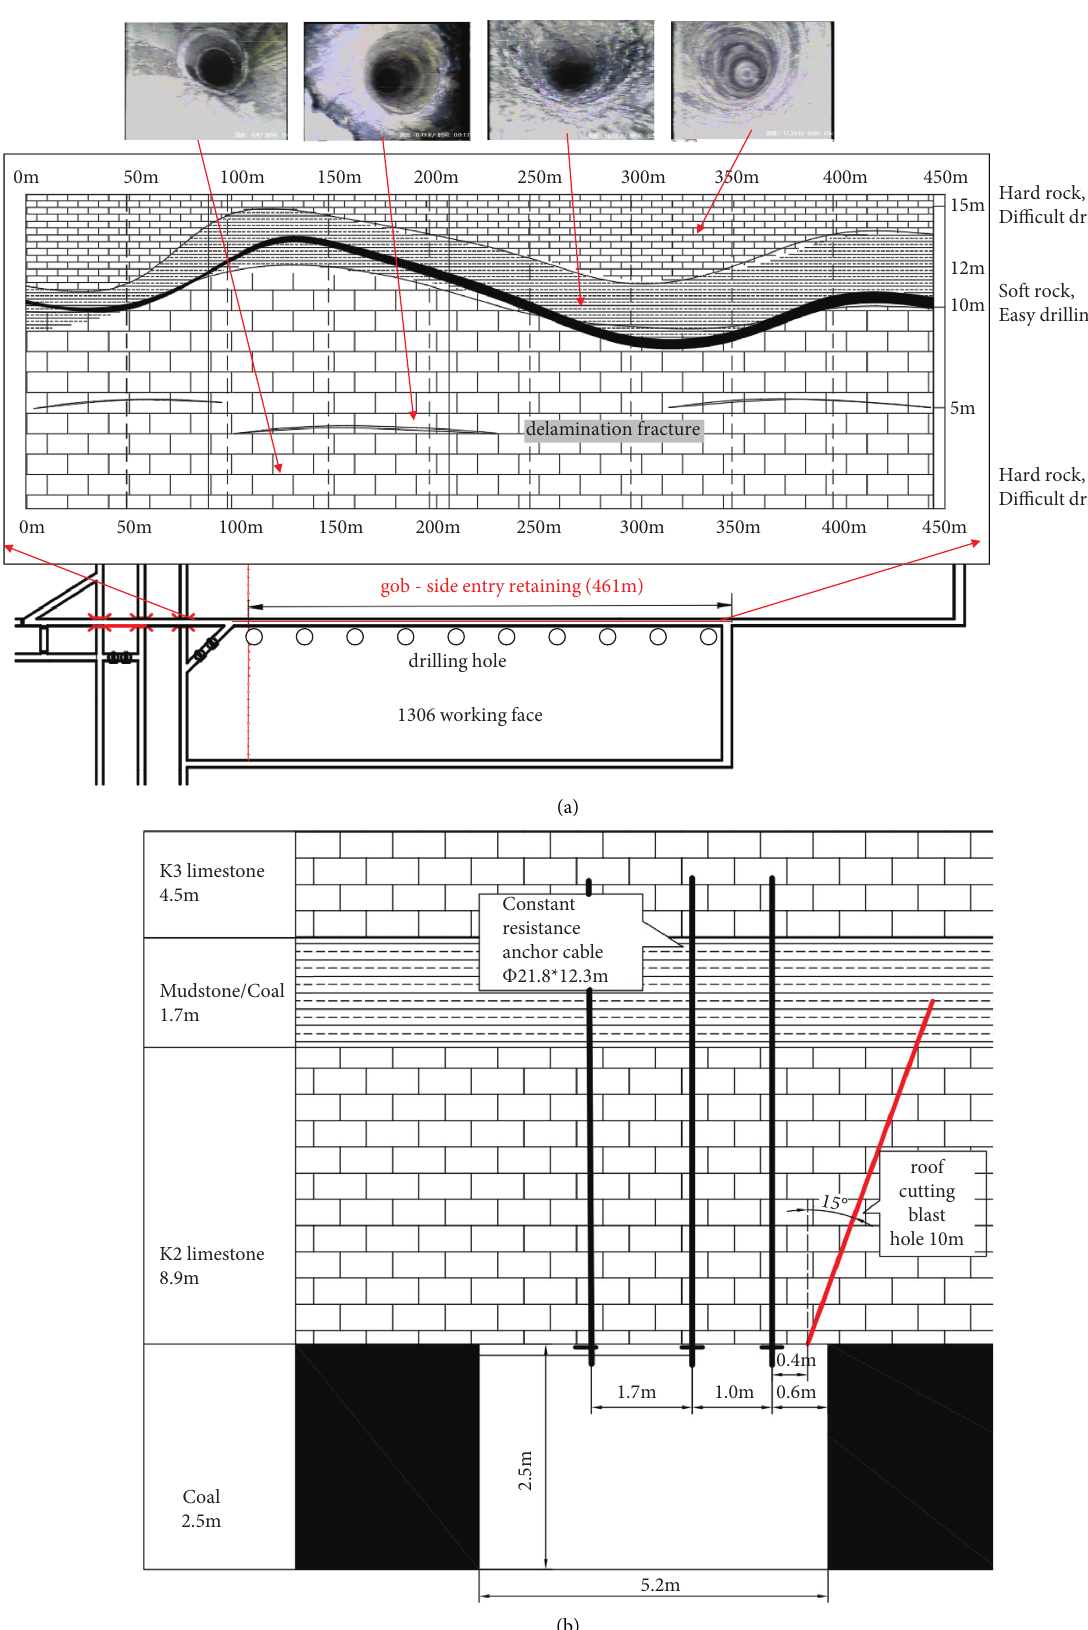
Figure 9: Roof lithology description and nonpillar mining design parameters. (a) The lithology within 15m of the roof of 1306 working face was drilled and photographed to form the lithology geological section map, which is the most important basis for the design of key parameters. (b) Two parameters are designed according to the roof lithology. The constant resistance anchor cable is designed in three columns and 12.3 m long. The blast hole length of the directional cutting roof is 10m and the drilling angle is 75 °